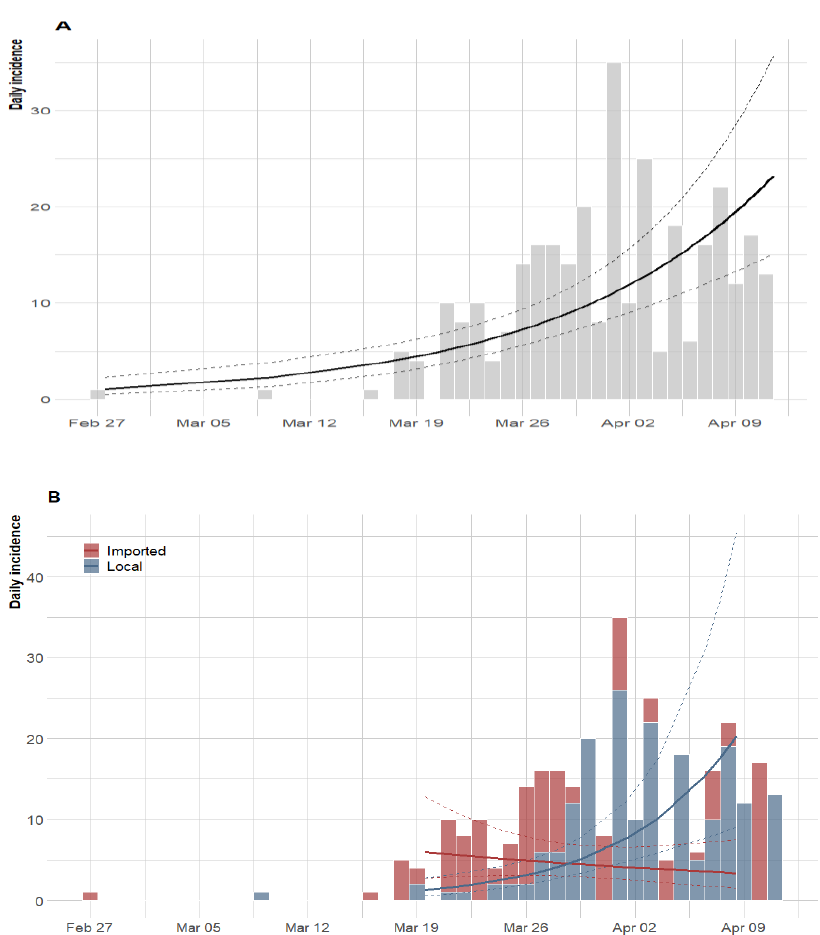
Figure 4. Epidemic curve of the confirmed cases of COVID-19 and the exponential growth fitting. ( A ) For all daily new cases, ( B ) disaggregated cases per transmission route as local or imported. The thick line represents the estimate surrounded by the 95% confidence interval (dashed lines).